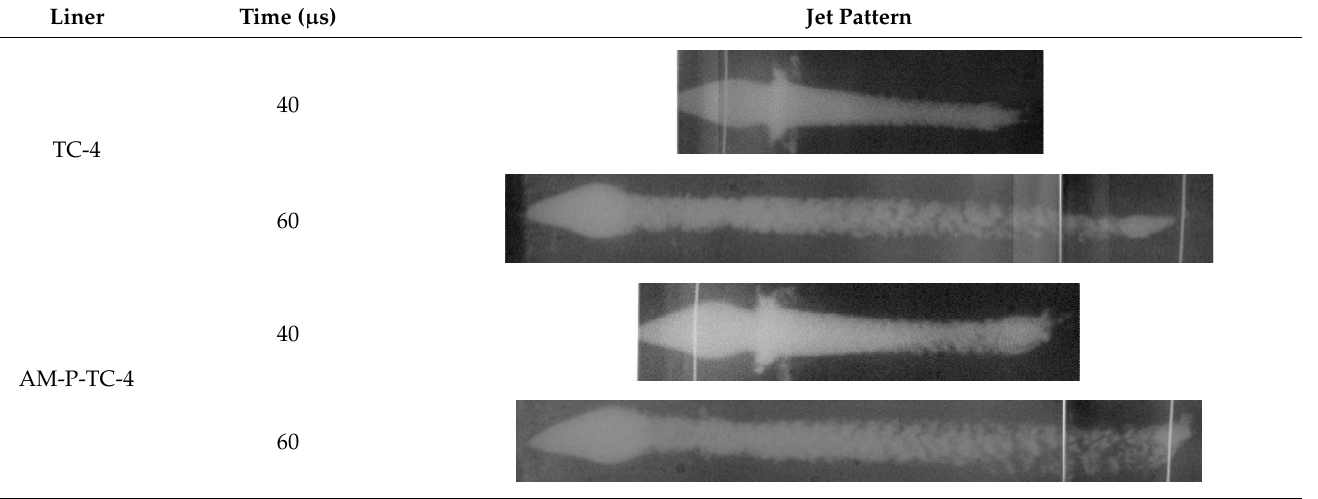
Table 4. Comparison of shape-forming of TC-4 and AM-TC-4 jets.